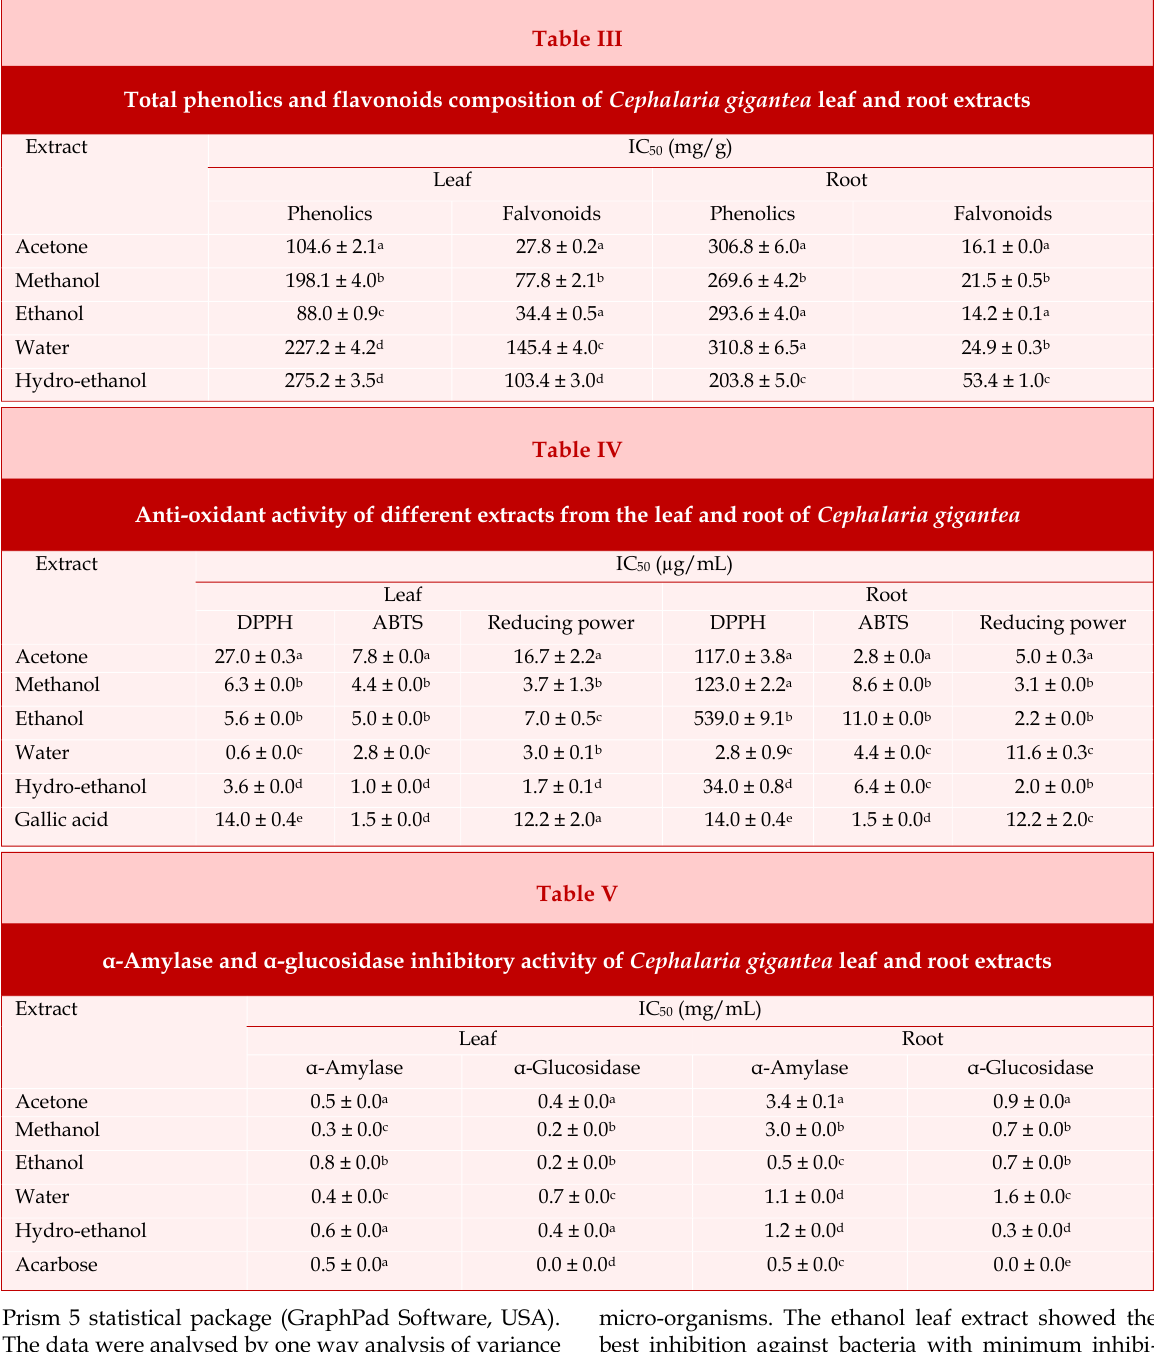
Prism 5 statistical package (GraphPad Software, USA). The data were analysed by one way analysis of variance (ANOVA) followed by Bonferroni test. All the results were expressed as mean ± SEM for triplicate determinations.